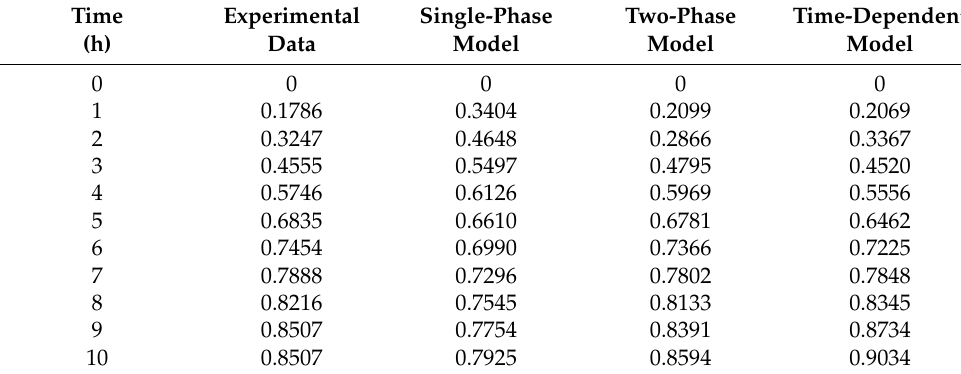
Table 2. The value for fractional drug release at each hour. Time Experimental Single-Phase Two-Phase